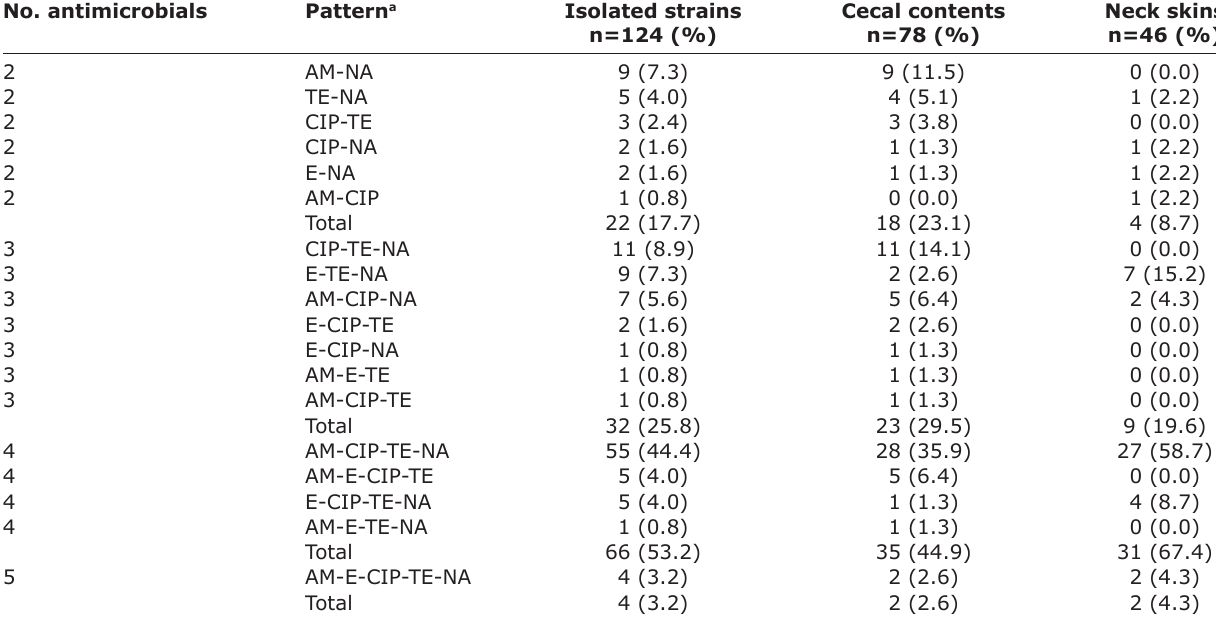
Table-5: Resistance patterns of thermophilic Campylobacter strains isolated from slaughterhouses. No.